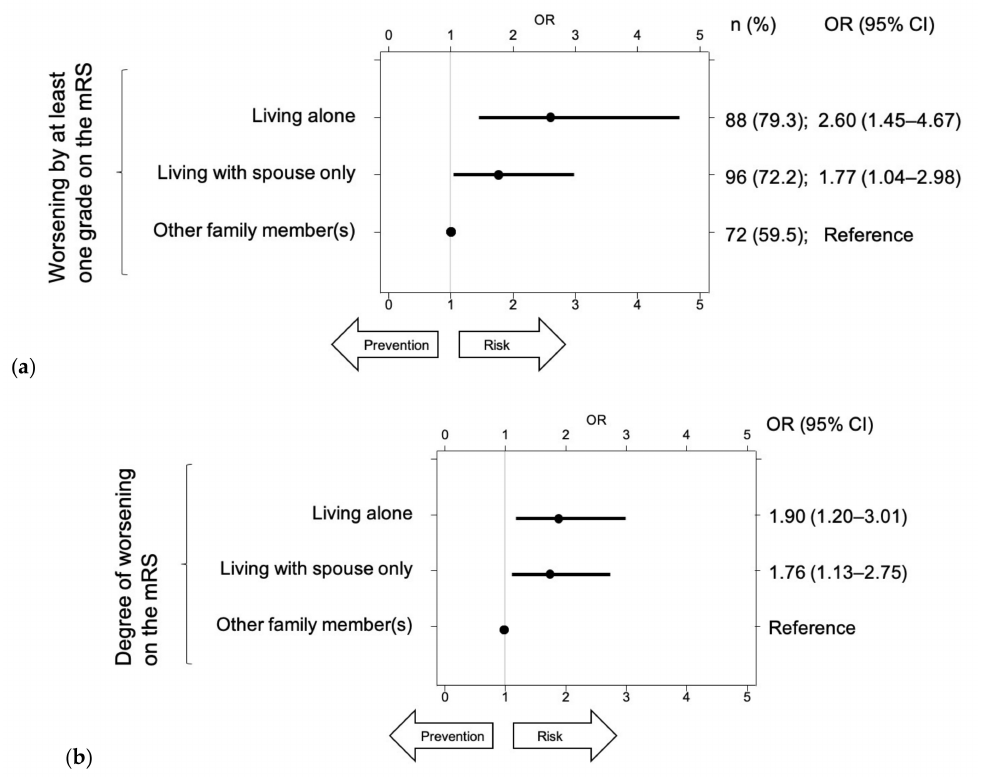
Figure 4. Odds ratios (ORs) for worsening mRS scores after a stroke: ( a ) worsening by at least one grade on the mRS after the stroke onset and ( b ) the degree of worsening on the